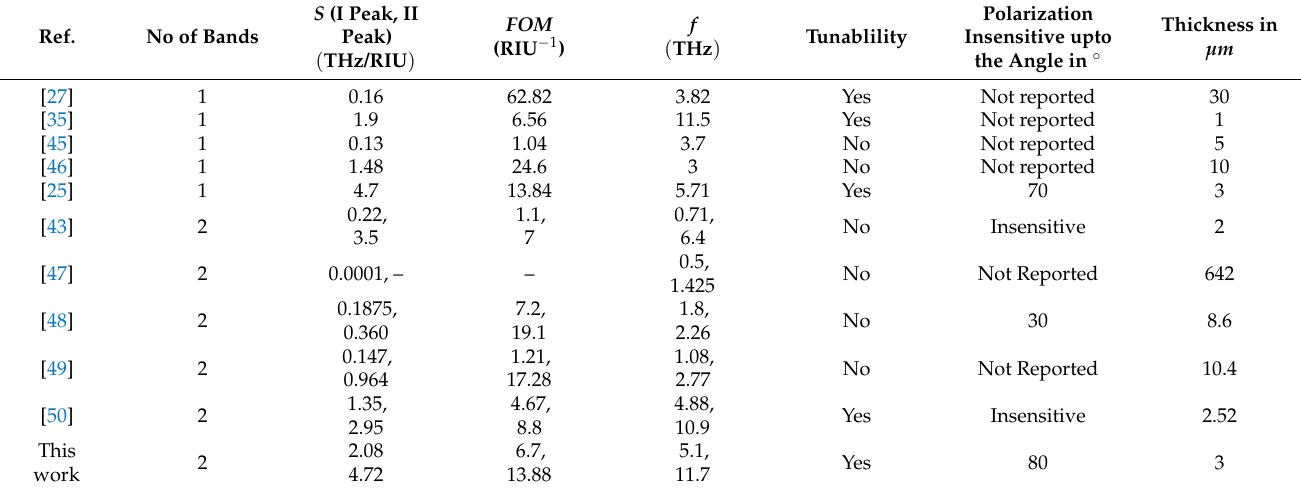
Table 4. Performance evaluation of the suggested absorber in contrast to the existing absorbers.